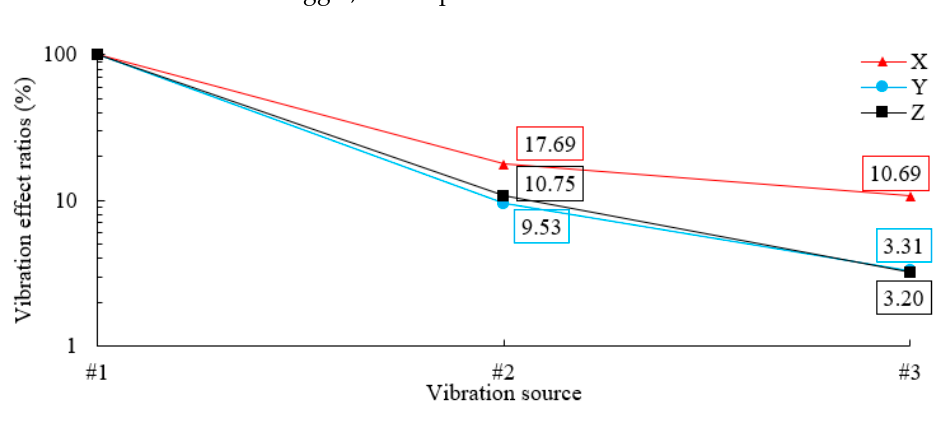
Figure 10. Vibration effect ratios by each unit.